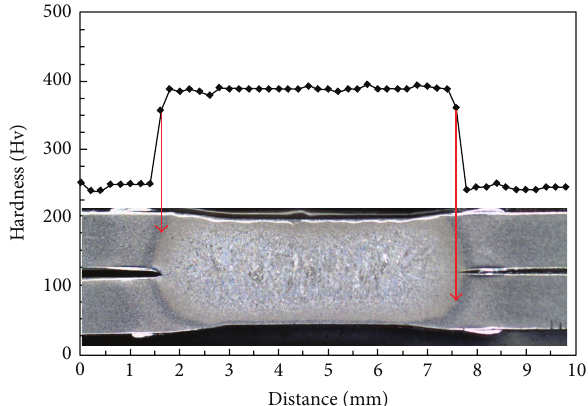
Figure 5: Cross-sectional shape and hardness profile of the specimen.